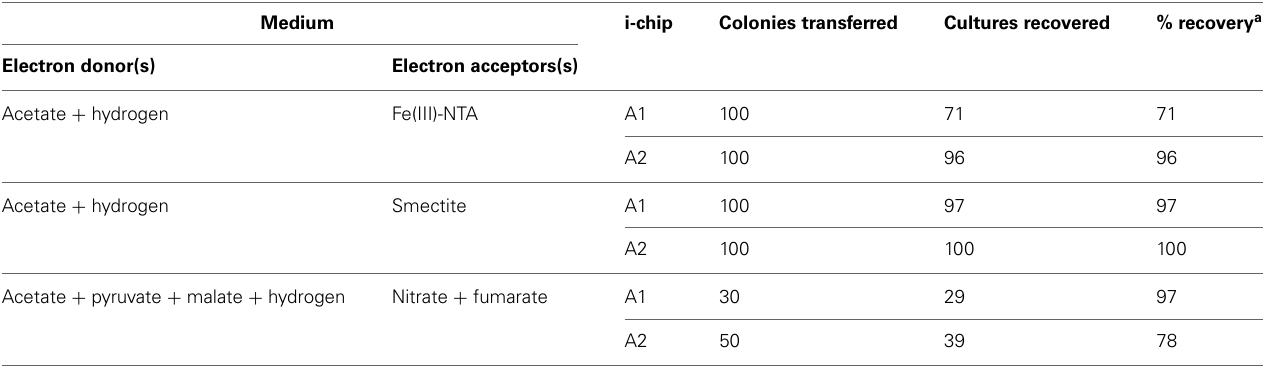
Table 2 | Microbial recovery from i-chips A1 and A3 (see Figure A1) targeting Fe(III)-reducing microorganisms.